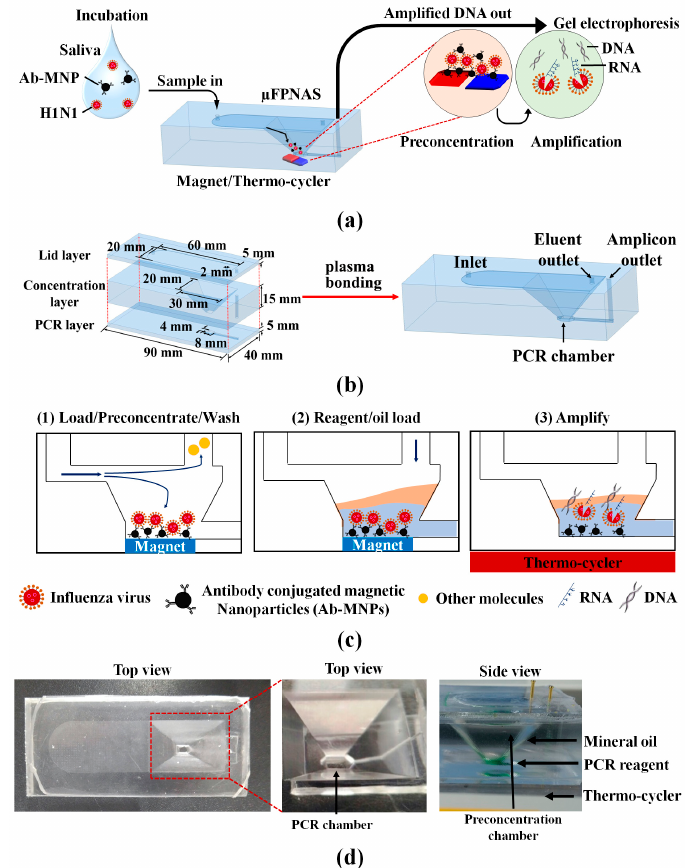
Figure 1. Design of microfluidic preconcentration and nucleic amplification system ( µ FPNAS) and its operation. ( a ) Its schematic describing on-chip preconcentration and nucleic acid amplification. ( b ) Its layers (top: lid, middle: concentration, bottom: polymerase chain reaction (PCR)), two chambers (preconcentration and PCR), and two inlets and two outlets showing their respective dimensions. ( c ) A schematic describing its operation protocol. ( d ) Images of µ FPNAS mounted on a on a heat block (10 cm × 10 cm) modified from C1000 Touch ™ thermocycler (Bio-RAD, Hercules, CA,